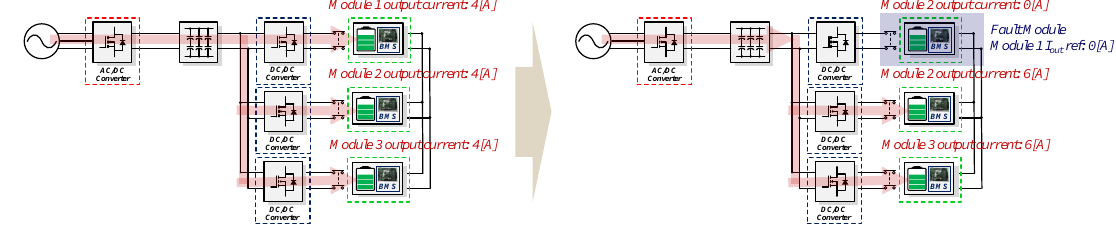
Figure 20. The battery charging current flow when determining fault module.